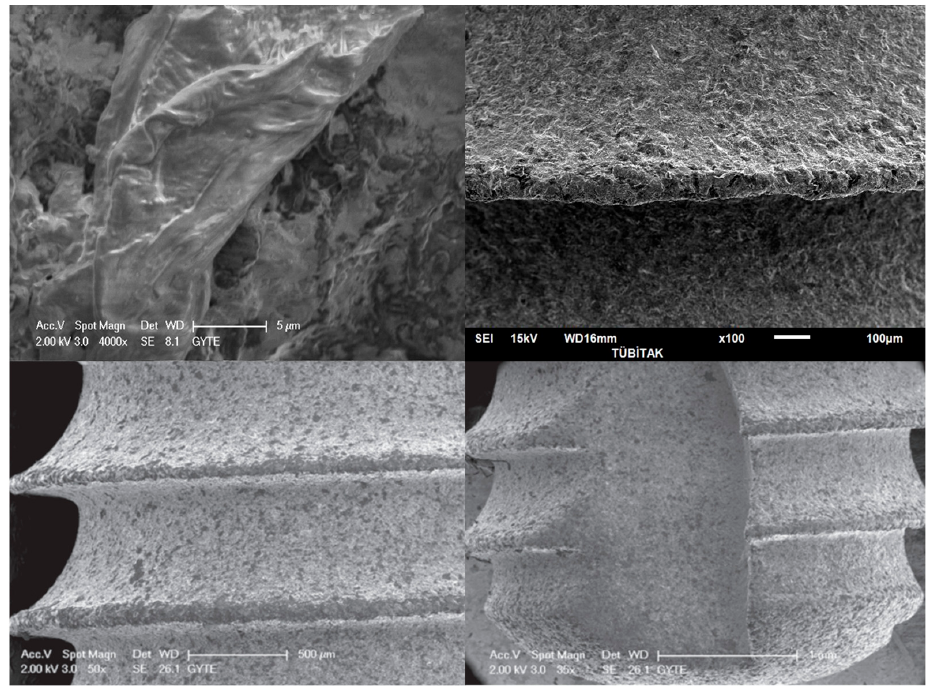
Figure 1. Scanning electron microscope images of the Grade V implant discs that were used in the present study. The magnifications of the images are ×4000 (upper left), ×100 (upper right), ×50 (lower left), and ×35 (lower right).